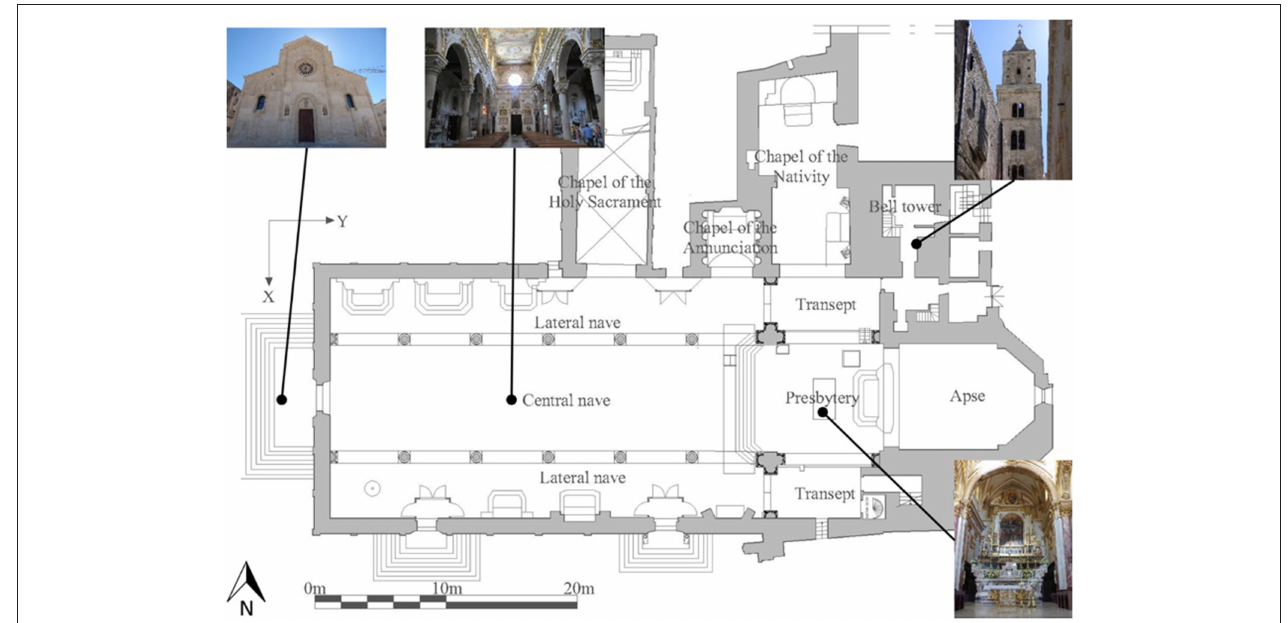
FIGURE 1 | Plan of the SS Maria della Bruna church (Ramirez et al., 2019).